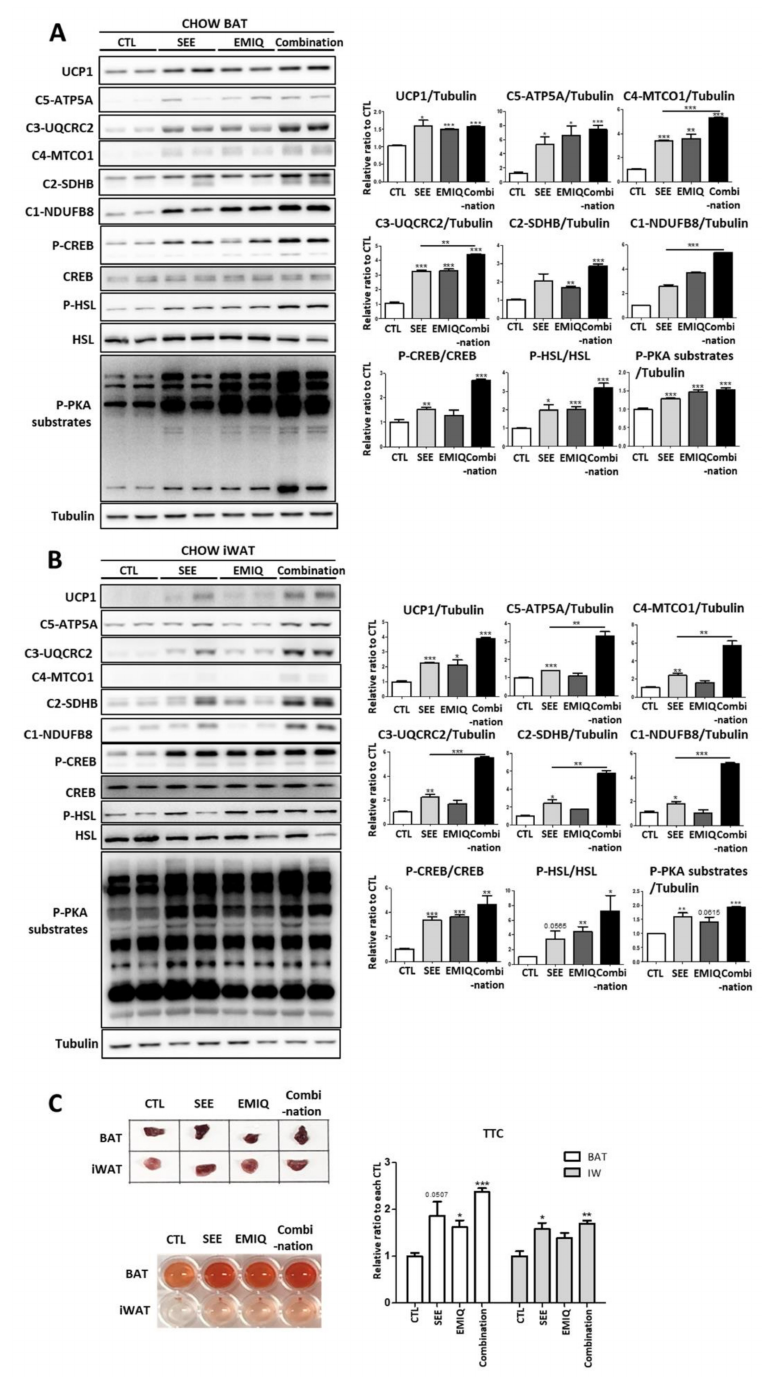
Figure 3. Effects of in vivo SEE, enzymatically modified isoquercitrin (EMIQ), and co-treatment (SEE + EMIQ) treatment on mitochondrial content and PKA signaling in adipose tissues. ( A , B )